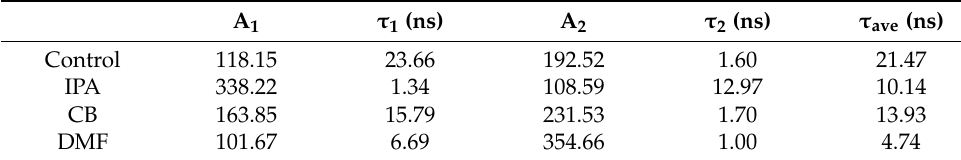
Table 1. The data for fitted TRPL curves.